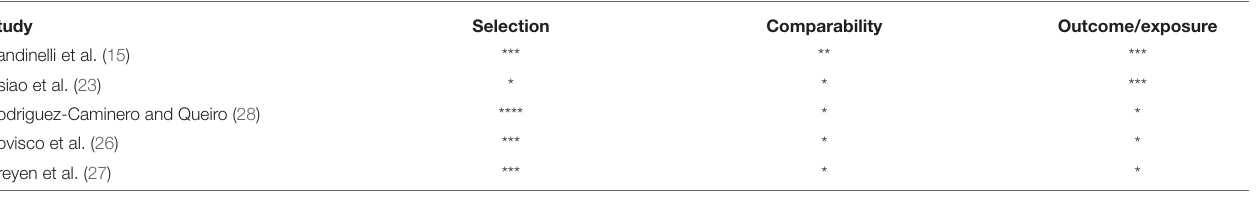
TABLE 3 | Assessment of the risk of bias. Newcastle-Ottawa Scale: each asterisk refers to the fulfillment of the items of the different components of the scale. QUADAS-2: green refers to a low risk of bias, yellow to unclear risk of bias and red to high risk of bias. What is the frequency of abnormalities, detected in the joints and in periarticular structures by ultrasonography, in patients with IBD without a diagnosis of arthritis? Newcastle-Ottawa Scale